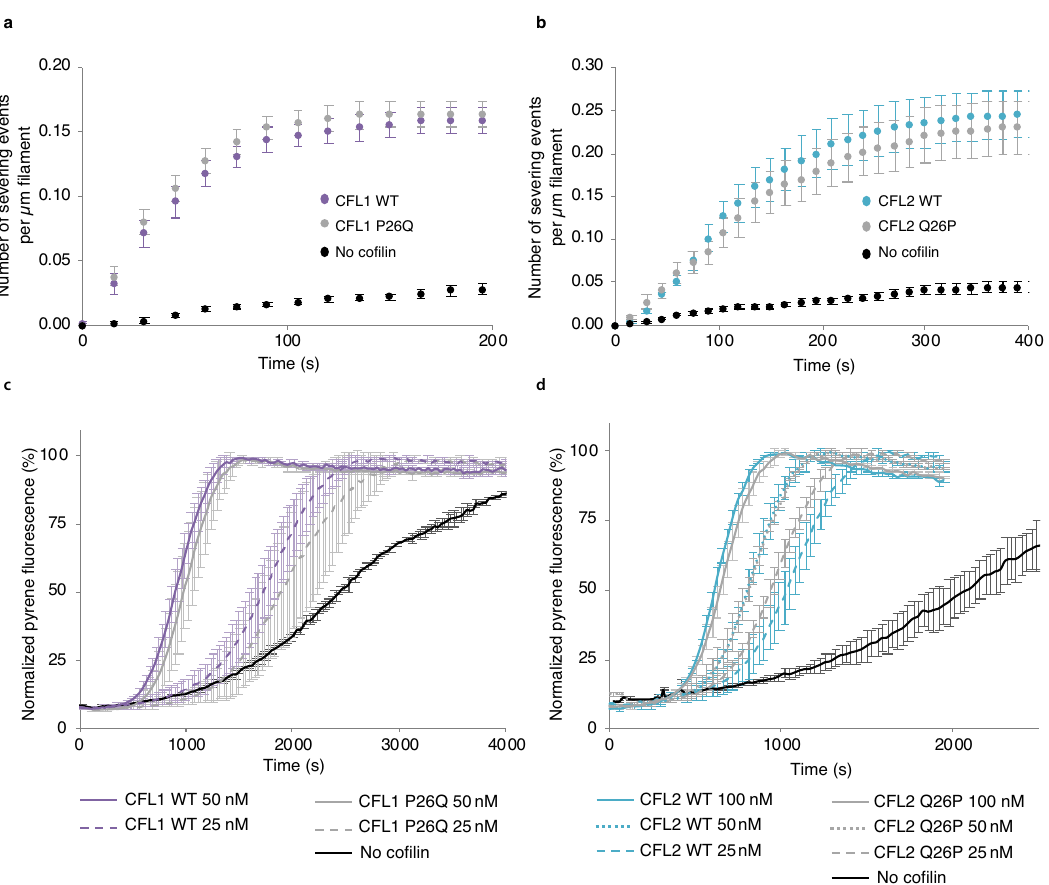
Fig. 4 In vitro F-actin severing by CFL1 and CFL2 mutants. F-actin severing activity of co fi lins was assessed through TIRFM analysis ( a , b ) and bulk pyrenyl-actin polymerization assays ( c , d ). a , b 0.9 μ M Alexa488-actin (33% labeled) was polymerized in a TIRF chamber followed by the addition of human co fi lins. Accumulation of severing events upon addition of ( a ) CFL1 WT (purple) and CFL1 P26Q (gray) or ( b ) CFL2 WT (blue) and CFL2 Q26P (gray) was counted and normalized per fi lament length prior to the addition of co fi lin. Due to its notably higher severing potency, CFL2 was added at a 12- nM concentration as compared to 120-nM of CFL1 to obtain similar severing rates. Data were presented as the mean of three independent experiments with four fi elds of view analyzed within each experiment; error bars represent the standard error of the mean. c , d 2.45 μ M pyrenyl-actin (5% labeled) was polymerized in the presence of 2.65 μ M pro fi lin-1 and indicated concentrations of co fi lin constructs (designated by solid and dashed lines). CFL1 WT is shown in purple, CFL1 P26Q mutant is shown in gray ( c ). CFL2 WT is shown in blue and CFL2 Q26P mutant is shown in gray ( d ). Fluorescence intensities were normalized to the highest signal for each trace. Experiments were conducted in duplicates; error bars represent the standard deviation of the